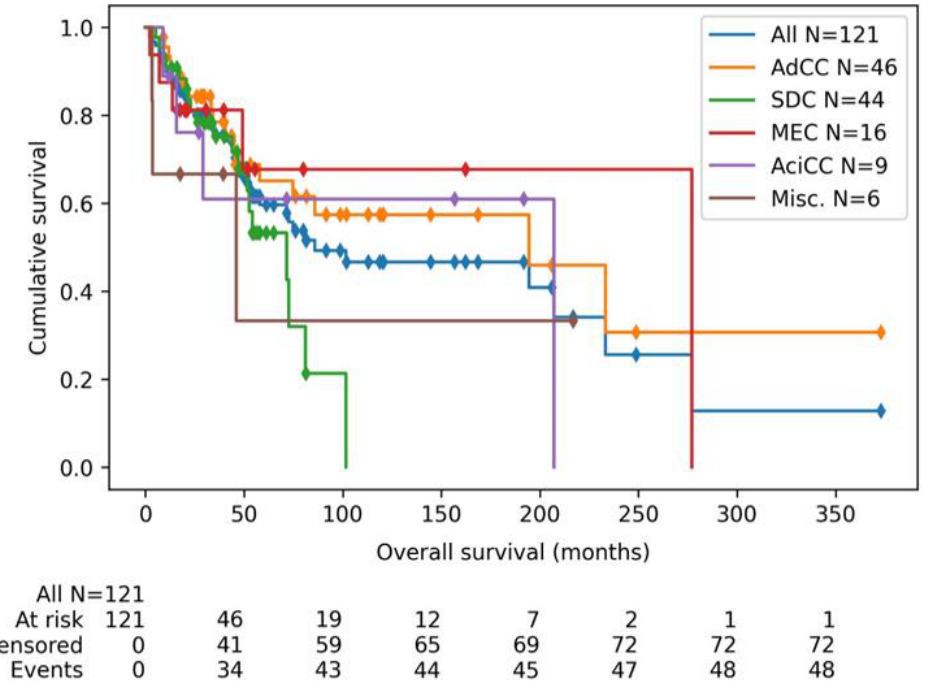
Figure 1. Kaplan–Meier curve of overall survival (from initial diagnosis until death), sorted per subtype and grouped for all subtypes together. All included patients are plotted, which is a mixed group regarding disease stage. Abbreviations: AdCC: adenoid cystic carcinoma, SDC: salivary duct carcinoma, MEC: mucoepidermoid carcinoma, AciCC: acinic cell carcinoma, Misc.: